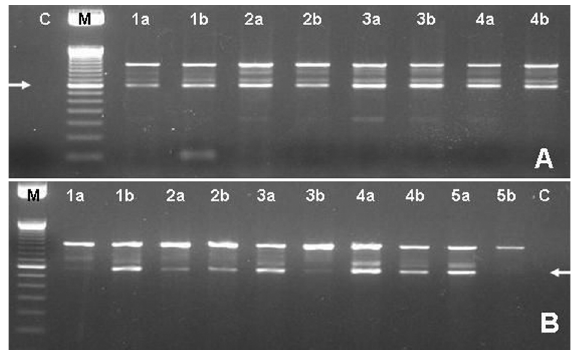
Figure 1 - Semi-quantitative multiplex RT-PCR for KLK2 gene expres- sion analysis of two samples of prostate tissues from patients with (A) prostate cancer (PCa) or (B) benign prostatic hyperplasia (BPH). We show the results for four PCa and five BPH patients each represented by two samples (lanes a and b) produced from tissue from independent pros- tate regions. The samples were analyzed in a multiplex reaction with a 534-bppositivefragmentofthe β -2M constitutivegene.C=negativecon- trolreactionforDNAcontamination.M=50-bpladdermolecularmarker. The white arrow indicates the 341-bp KLK2 gene fragment. The faint band (378 bp) over the 341-bp fragment is the alternative splicing of the KLK2 gene.